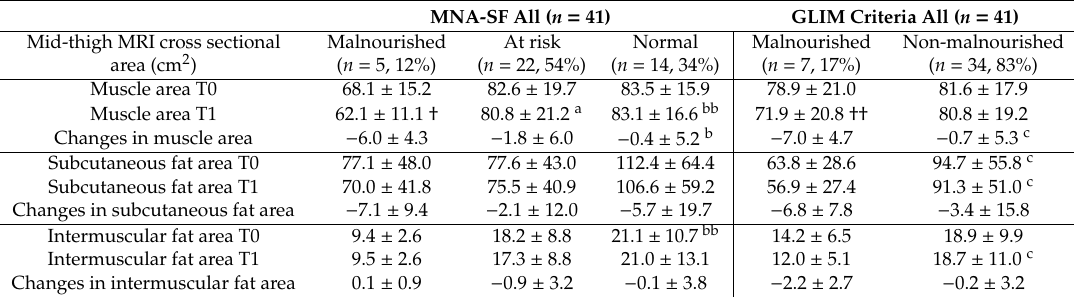
Table 2. Comparison of mean mid-thigh MRI cross sectional area (cm 2 ) of study population stratified by nutritional status at baseline (T0) and follow-up (T1) and the respective changes. MNA-SF All ( n = 41) GLIM Criteria All ( n = 41) Mid-thigh MRI cross sectional At risk Normal area (cm 2 ) ( n = 22, 54%) ( n = 14,